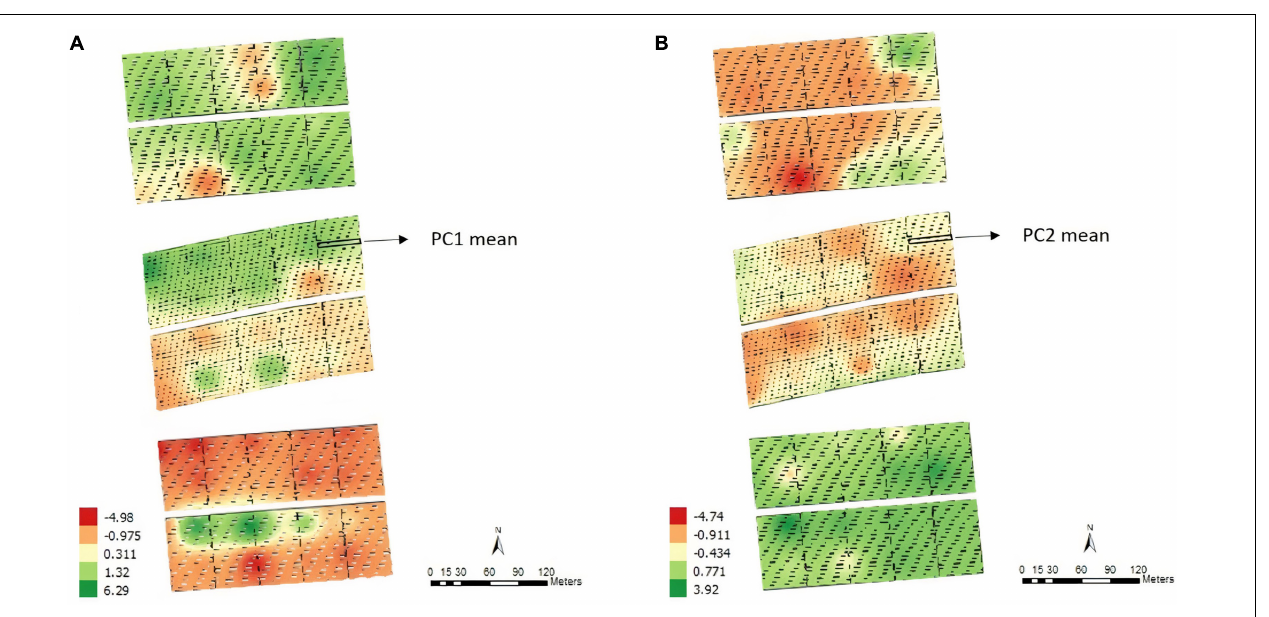
possible to note different patterns of variability, which shows that the soil is not uniform throughout the